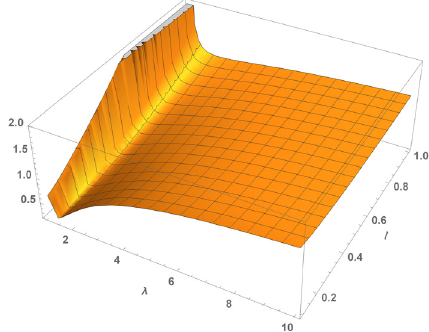
(b) The ratio of the induced current to the semi- classical current J / J sem is plotted as a function of λ and (cid:31) , in the lowest Landau state n = 0 with µ =